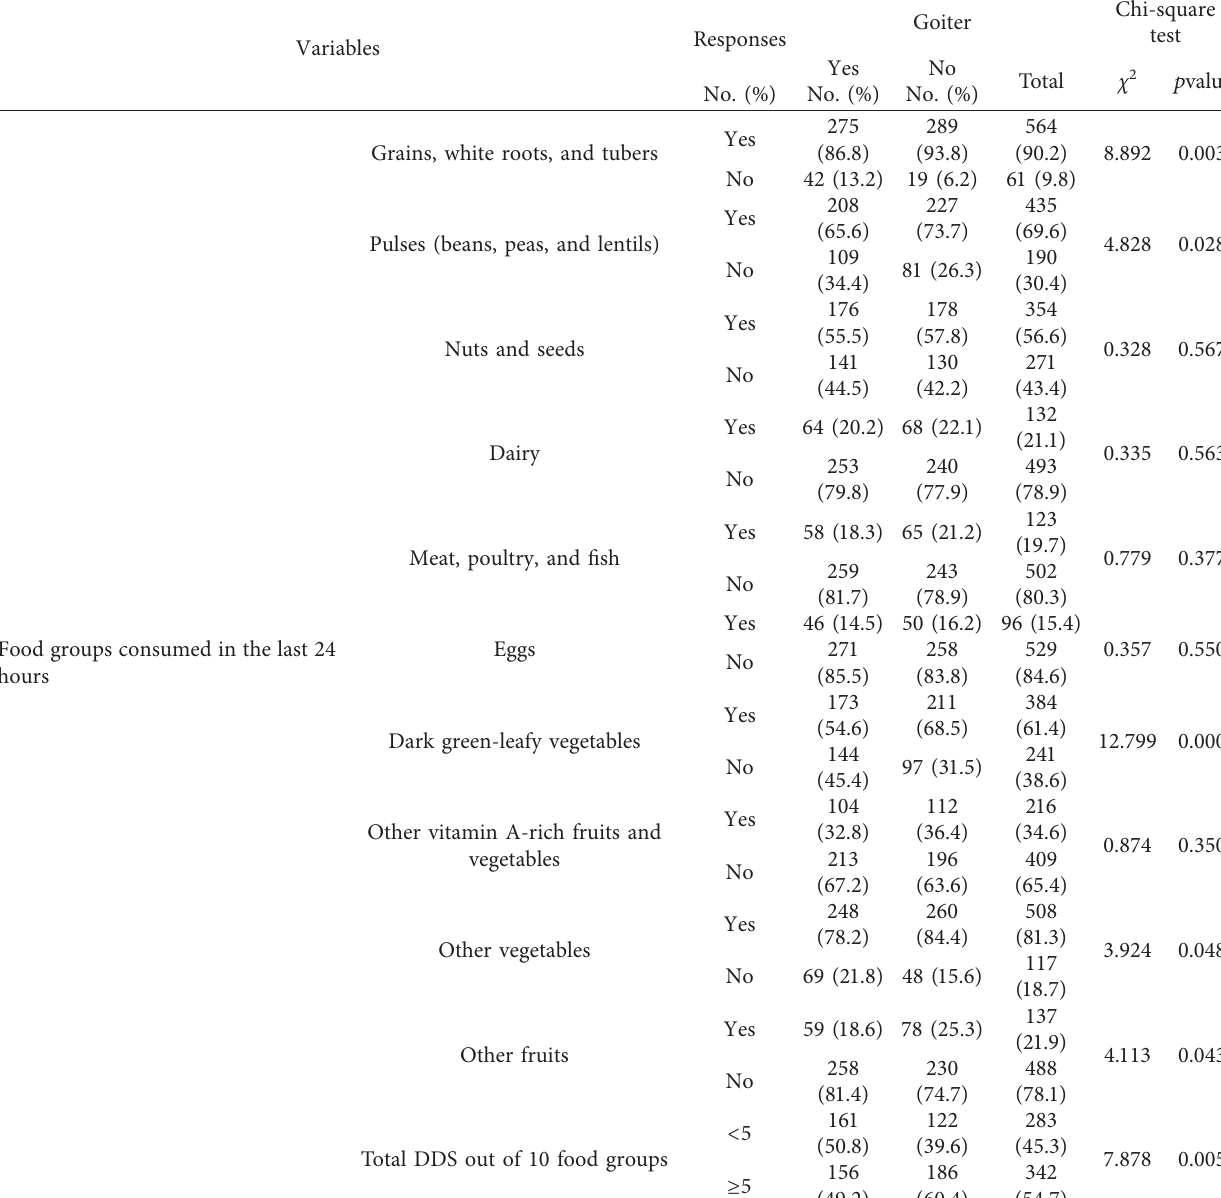
Chi-square Goiter